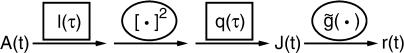
Generalized Cascade Model of the Auditory Transduction ChainThe model is composed of a sequence containing two linear temporal filters, l(τ) and q(t), and two static nonlinear transformations, namely a quadratic nonlinearity and an output nonlinearity g˜(·), which may differ from the nonlinearity g(·) of the click-stimulus model (see Protocol S1). First, the stimulus A(t) is convolved with the filter l(τ) (linear integration). Second, the result is squared (nonlinear transformation). Third, the result of the previous step is convolved with the filter q(τ), yielding the effective stimulus intensity J(t) (linear integration). Fourth, a final transformation g˜ of J(t) (nonlinear transformation) determines the response, which in this generalized model is the time-dependent firing rate r(t). The model thus corresponds to an LNLN cascade. This abstract structure directly follows the sequential configuration of the biophysical processing steps shown in Figure 1.